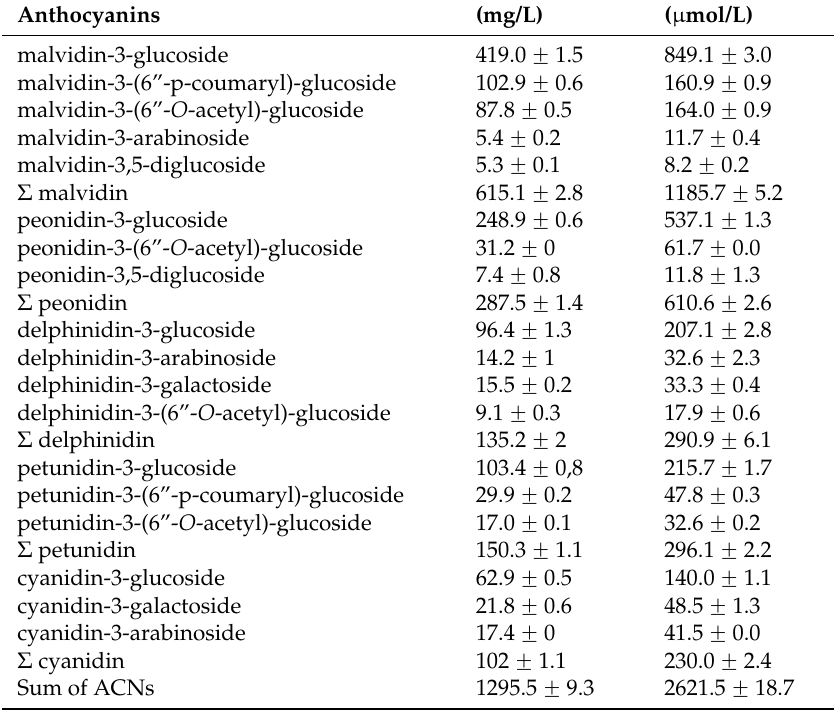
Table 1. Anthocyanins (ACNs) in grape/berry extract. The extract was analyzed by HPLC-PDA/ESI- MS; ACN concentrations are given as mg/L and µ mol/L (mean ˘ SD, n =